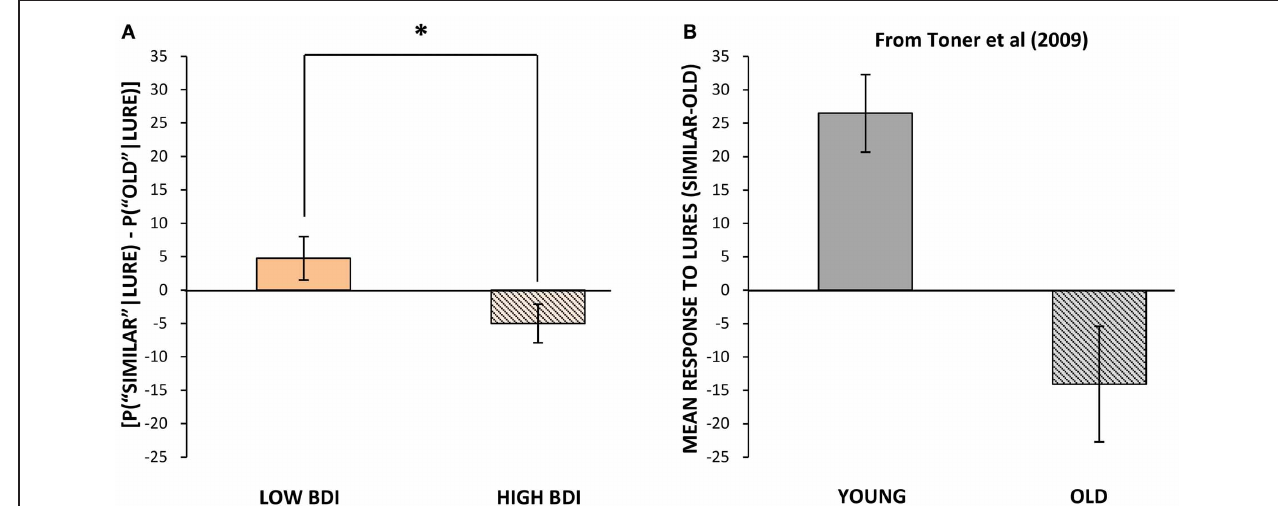
FIGURE 4 | Mean bias toward pattern separation vs. pattern completion (mean probability of correctly identifying lures as “similar” minus probability of misidentifying lures as “old,” ± standard error) vs. BDI score in Experiment 2 (A) and vs. age in Toner et al. (B). (A) Mean bias